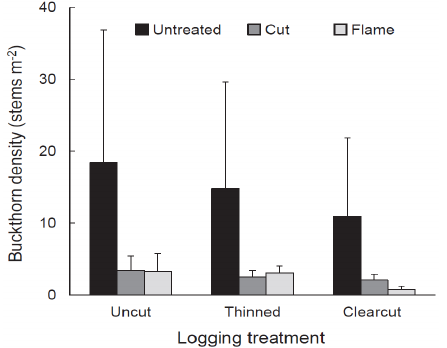
Figure 1. Density of glossy buckthorn (stems m − 2 ) in relation to logging treatment (uncut control, thinned, clearcut) and buckthorn treatment (untreated, cut, flame) at MacDonald Lot, Durham, NH, USA, in 2012, the third year after logging. n = 27 subplots.